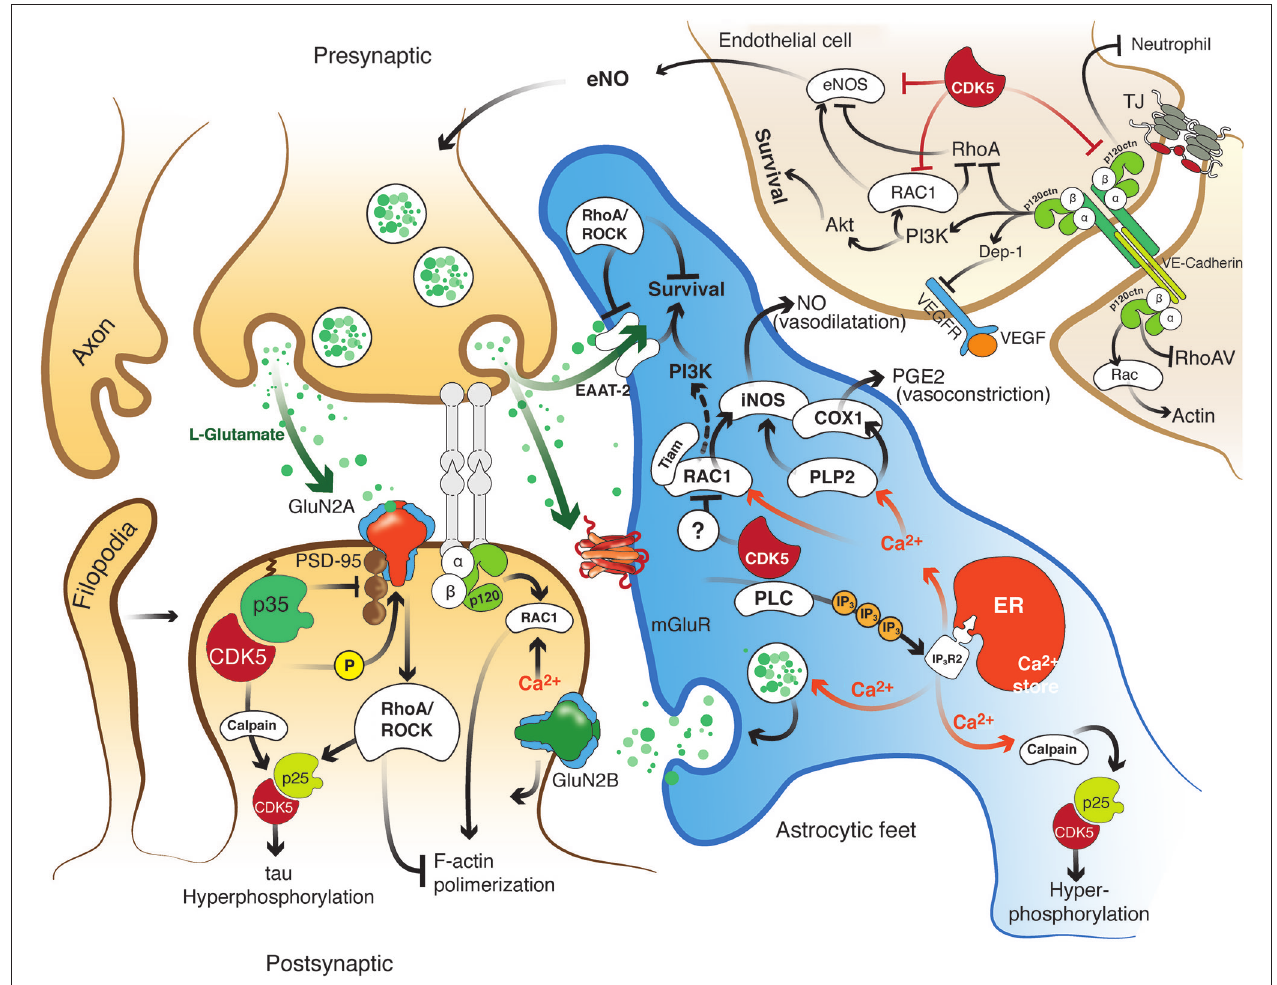
uptake in astrocytes, preserve actin remodeling and promote angiogenesis via eNOS activation. In turn, ROCK inhibition also prevents tau hyperphosphorylation and dendritic spine retraction and increases the expression of EAATs to enhance glutamate uptake and promote BBB integrity. Moreover, actin remodeling induced by Tiam/Rac1 favors stellation and survival in astrocytes. Likewise, the signaling molecules VE-cadherin and p120 catenin activate Rac/PI3 kinase and suppress RhoA to maintain the survival and organization of the actin cytoskeleton, form complexes with VEGFR-2 to promote BBB adhesion and integrity, and prevent neutrophil diapedesis. ROCK and CDK5 targeting may promote calcium wave stimulation via glutamate receptor and PLC/IP3 signaling in astrocytes to facilitate NO and PGE2 release, thus regulating endothelial vasodilatation and